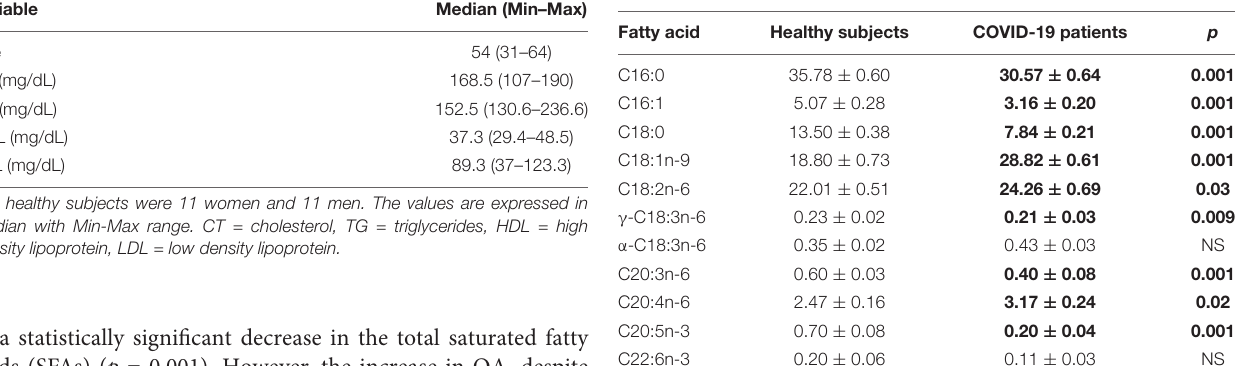
TABLE 2 | Age range and serum biochemical of the healthy subjects. TABLE 3 | Total fatty acid compositions in the plasma from the healthy subjects and COVID-19 patients.